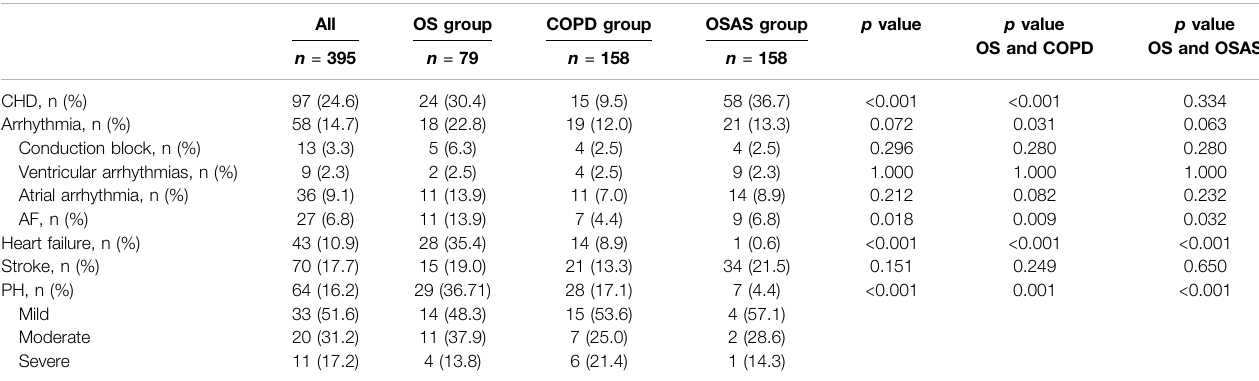
TABLE 4 | Incidence of cardiovascular diseases in study patients.